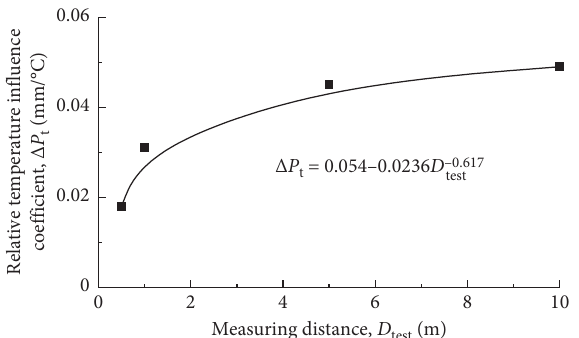
Figure 10: The relationship between measuring distance and relative temperature influence